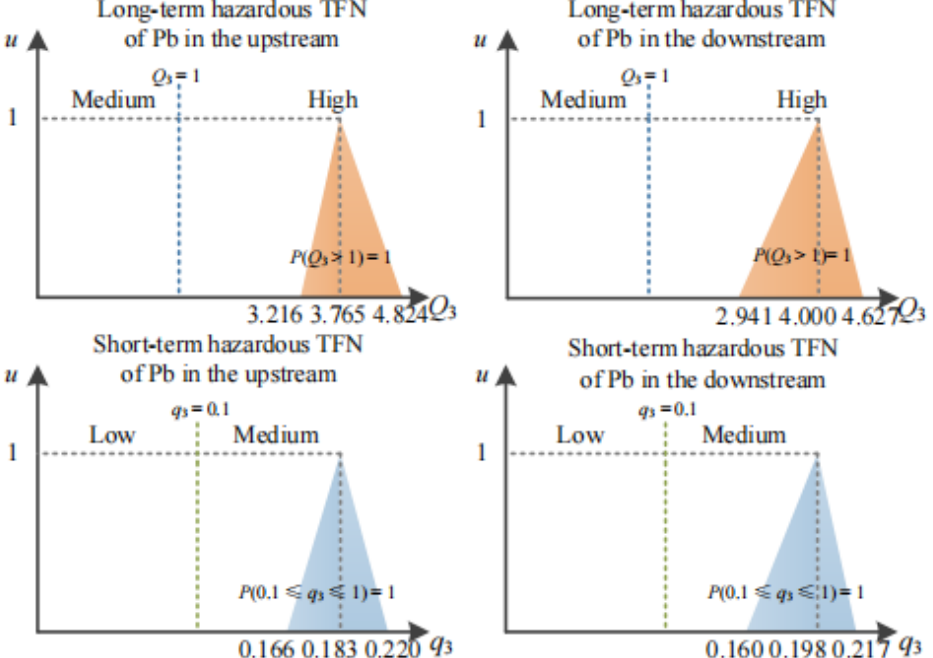
Figure 10. Hazardous TFNs of Pb before dam construction.